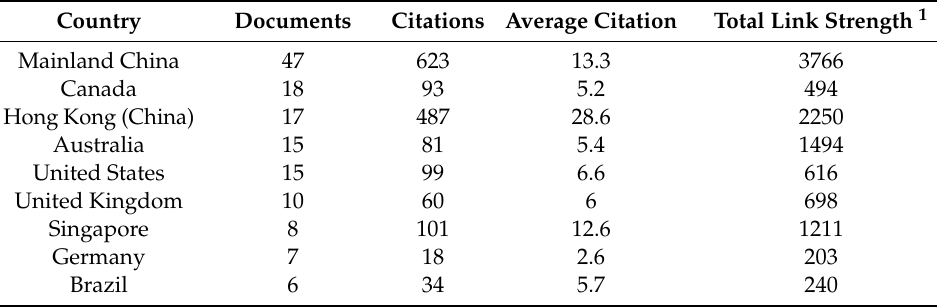
Table 1. Analysis of the countries of origin of the published